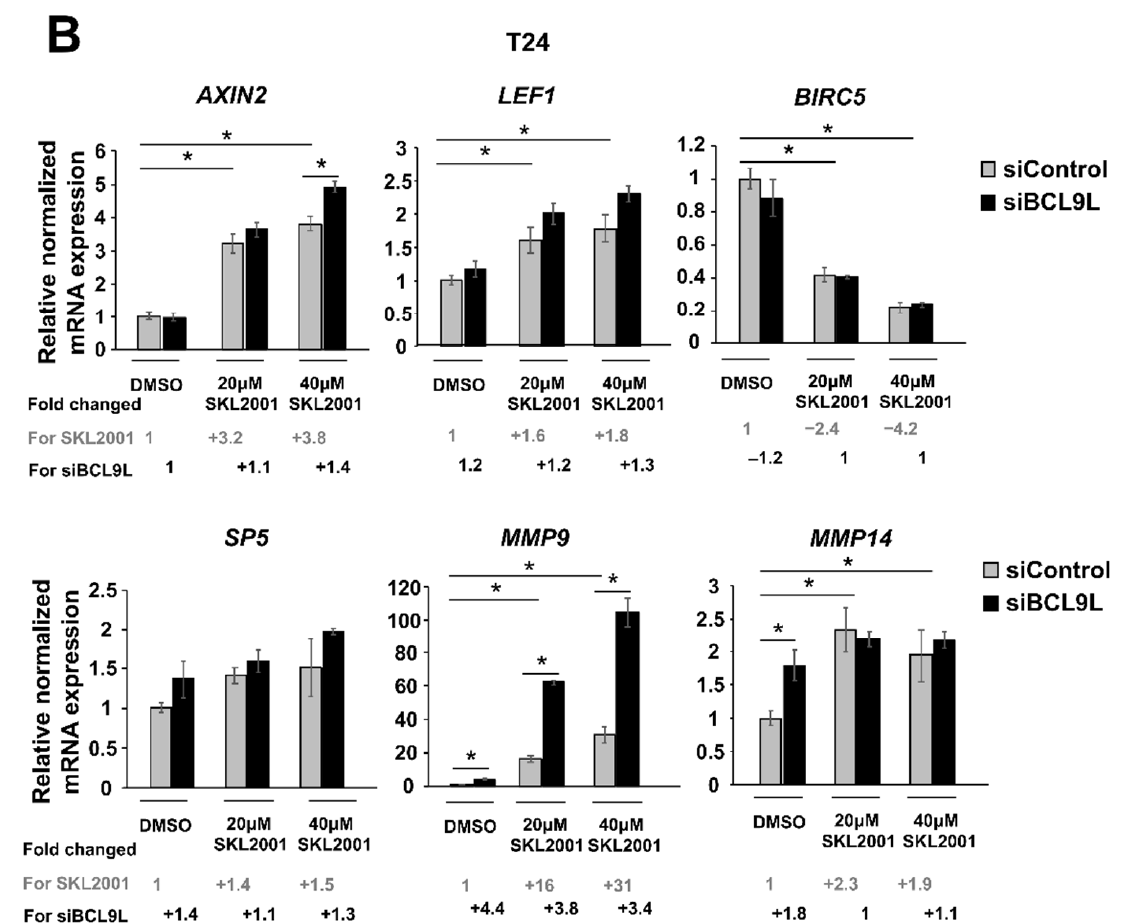
Figure 6. Repression of Wnt/ β -catenin signalling by BCL9L knockdown is cell-line-specific in BC. ( A , B ) mRNA expression of Wnt/ β -catenin target genes after siBCL9L and SKL2001 co-treatment Cal29 ( n = 3) ( A ) and T24 ( n = 3) ( B ). Cells were transfected with siBCL9L or siControl and next day were treated with Wnt/ β -catenin activator (SKL2001) at different concentrations: 40 µ M and 20 µ M. 2 days later the mRNA expression of Wnt/ β -catenin target genes AXIN2 , LEF1 , SP5 , BIRC5 , MMP9 , and MMP14 were analysed by qRT-PCR. Fold change and significance for different concentrations of SKL2001 compared to the negative control (DMSO + siControl) is indicated in grey. Fold change and significance of siBCL9L compared to each SKL2001 treatment or DMSO is indicated in black. The data are shown as relative to the negative control (DMSO + siControl) and are expressed as mean ± standard deviation. (* p -value < 0.05, Mann–Whitney U -test, n : independent biological rep- licates.